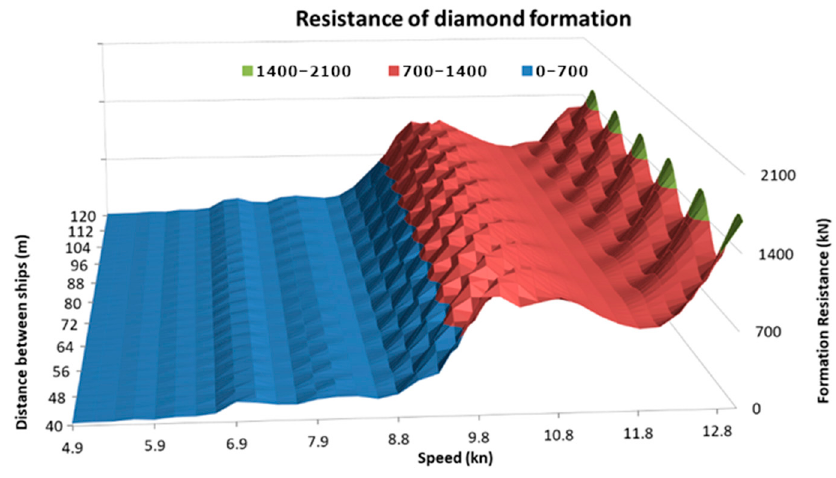
Figure 12. Total resistance of a formation composed of four tugboats sailing in a diamond-shaped formation.